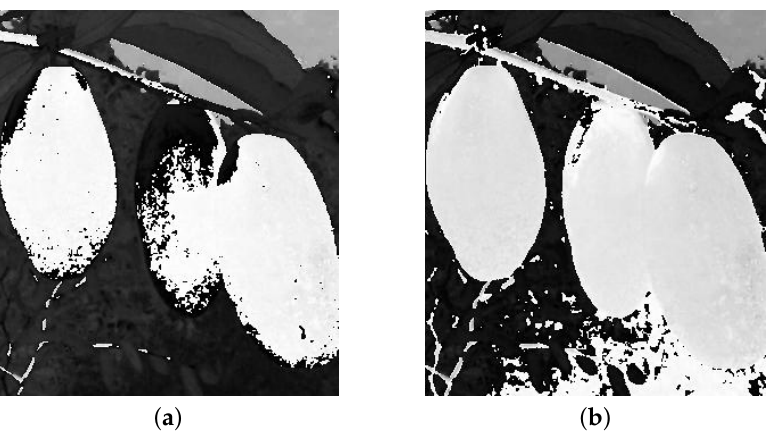
Figure 11. The images with different rotary angles. ( a ) Small rotary angle. ( b ) Large rotary